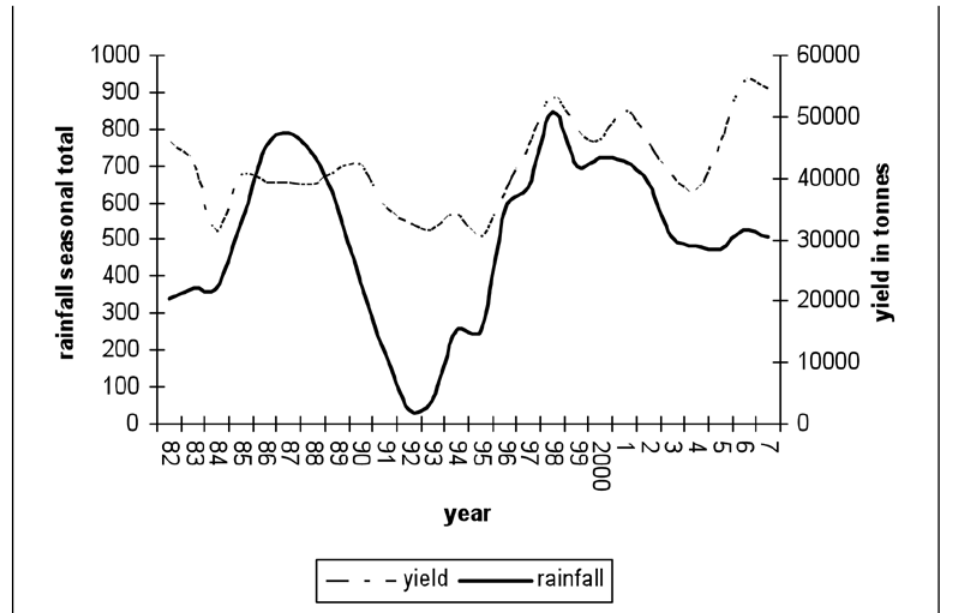
Source: Zimbabwe Department of Meteorological Fig 3. Rainfall and cotton output scenarios in Gokwe District